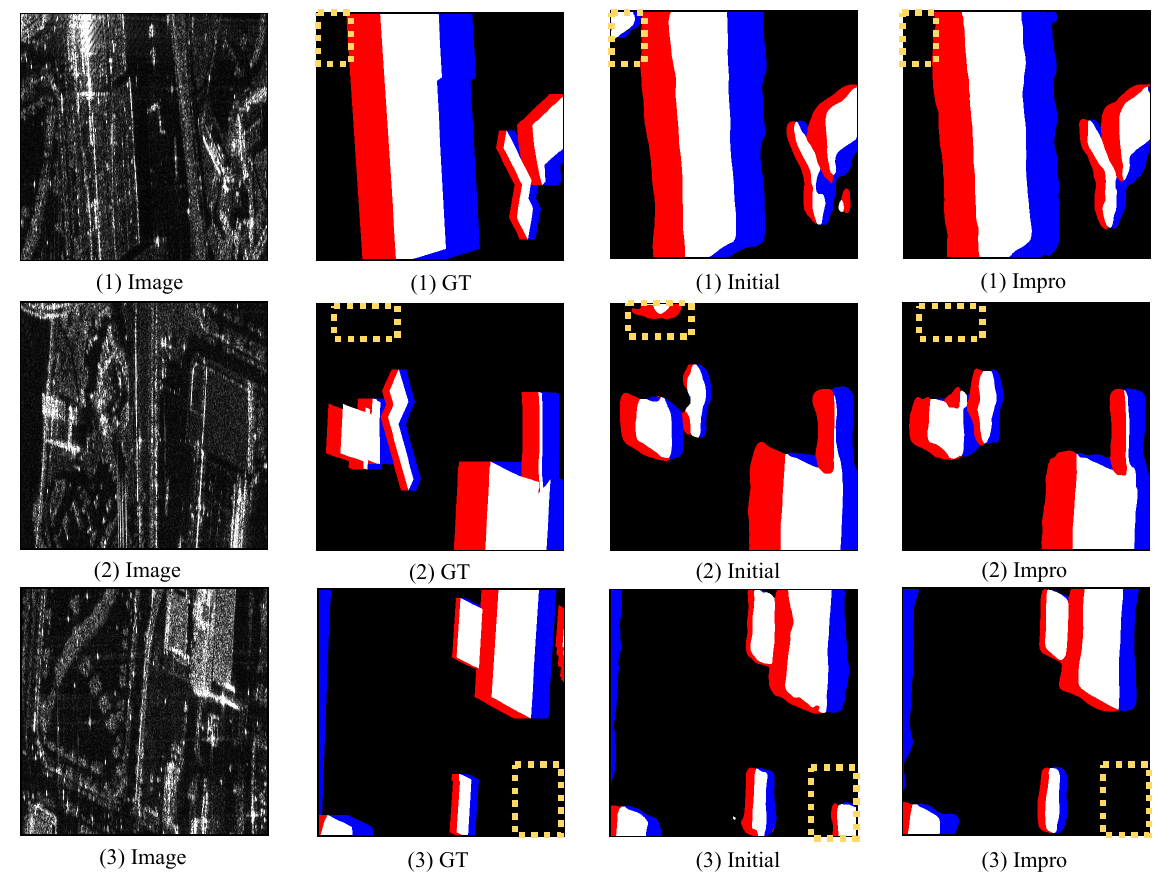
Figure 12. Comparison of the inference effects of our proposed network before and after adding the auxiliary